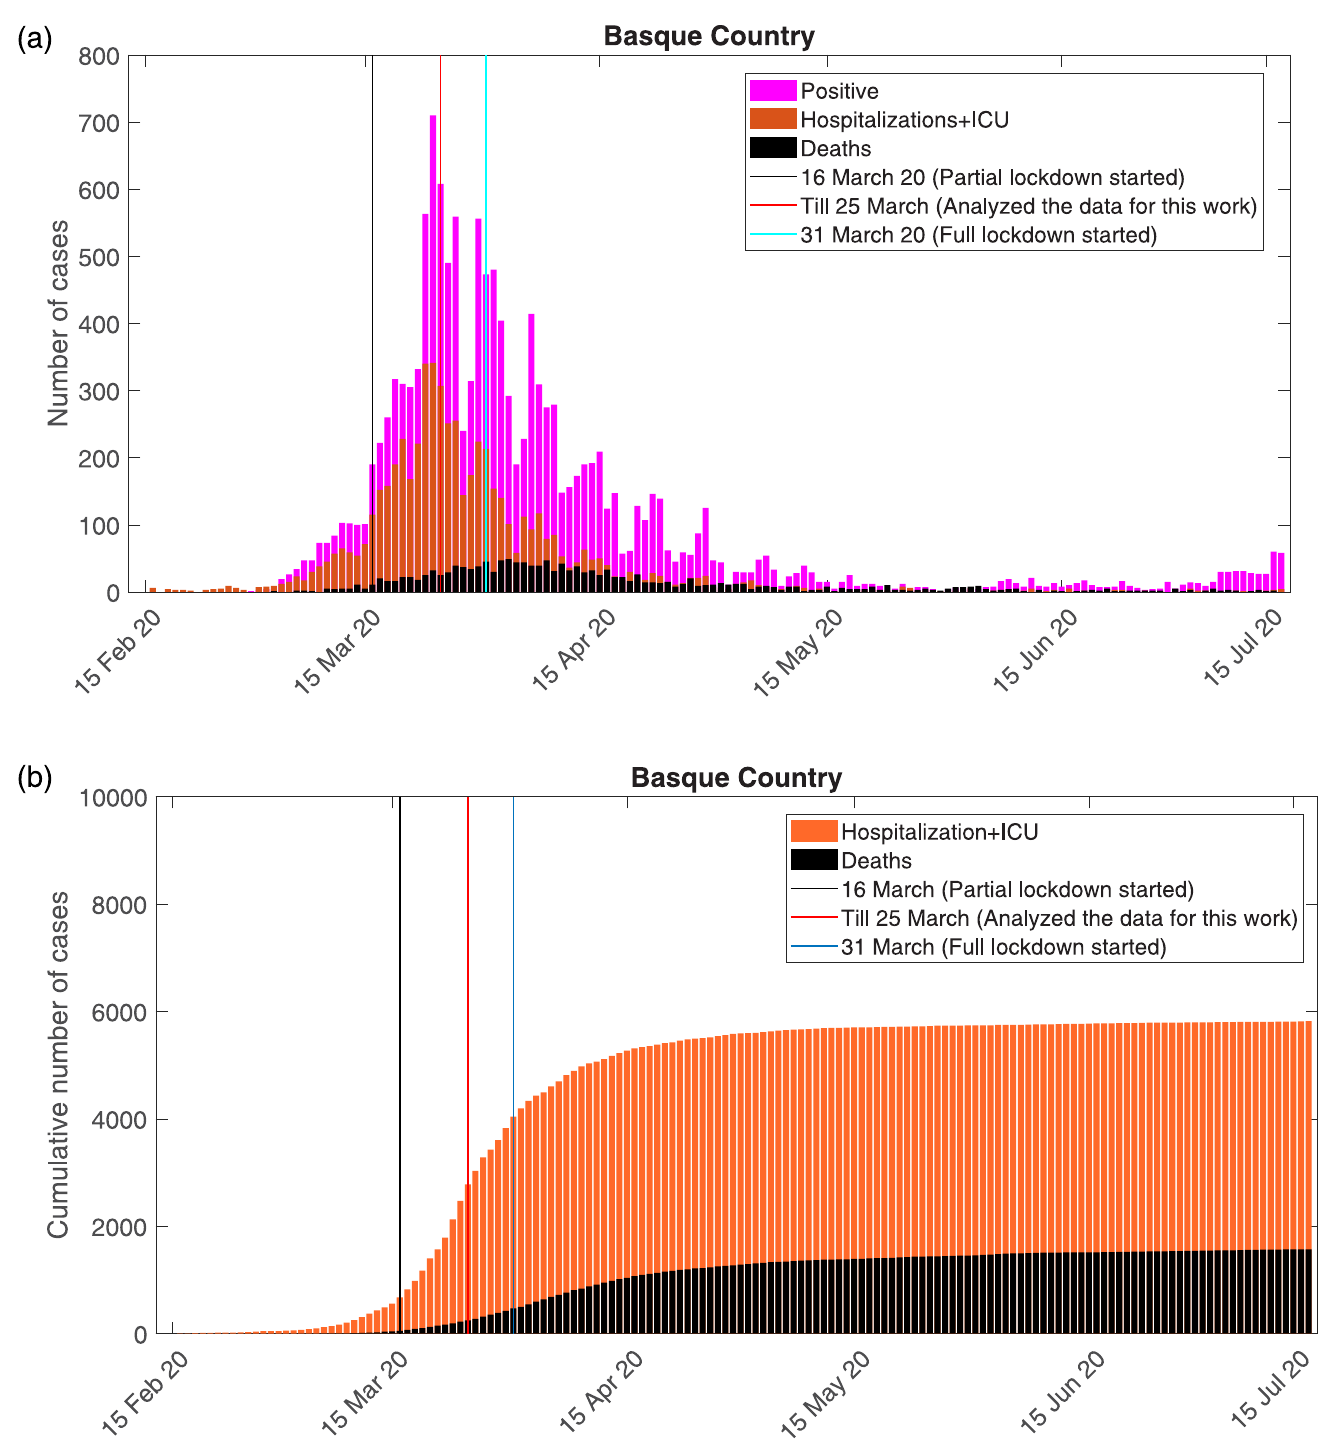
Fig 9. COVID-19 epidemiological data in the Basque Country. In (a) the cumulative hospital admissions and deceased cases. In (b) incidences for disease cases referring to hospitalizations including ICU and deaths.